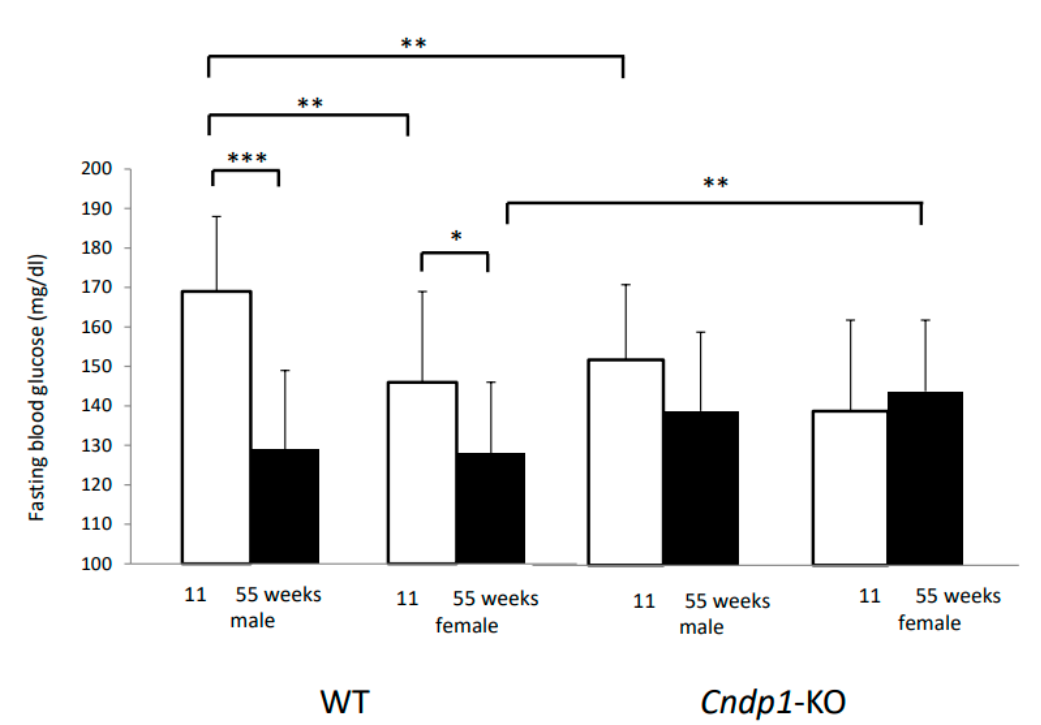
Figure 7. Fasting blood glucose, after 5 h fasting, decreased with age in WT mice ( p < 0.05) but not in Cndp1-KO mice. (11 weeks male Cndp1 -KO: n = 15; 11 weeks male WT: n = 17; 11 weeks female Cndp1 -KO: n = 14; 11 weeks female WT: n = 17; 55 weeks male Cndp1 -KO: n = 38; 55 weeks male WT: n = 12; 55 weeks old Cndp1 -KO female: n = 23; 55 weeks old female WT: n = 17). *: p < 0.05; **: p < 0.01; ***: p < 0.001.